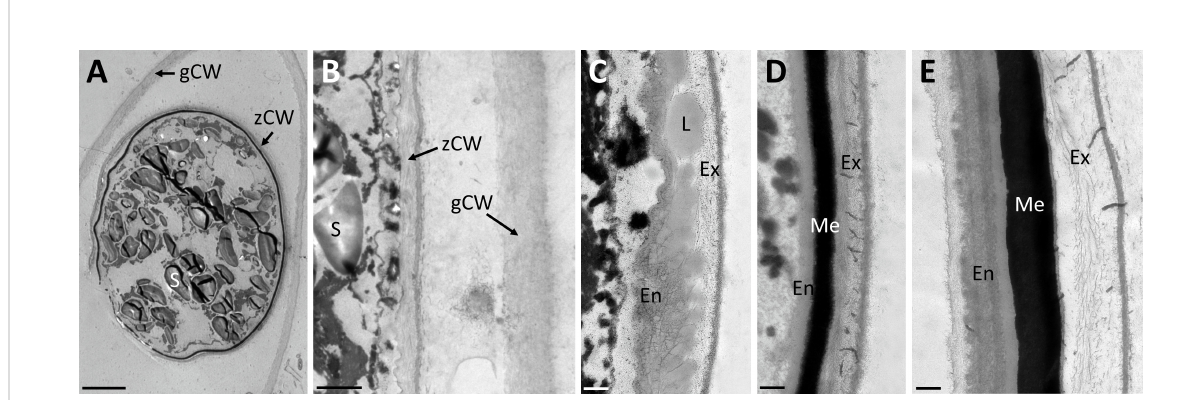
FIGURE 3 Transmission electron micrographs of high pressure frozen/freeze substituted Spirogyra mirabilis zygospores. (A) overview of a presumably young zygospore; (B) zygospore wall at an early developmental stage, comprising only two thin main layers; (C) accumulation of lipid bodies between the endo- and exospore when the mesospore is not fully developed; (D) detail view of mature zygospore wall; (E) detail view of mature zygospore wall with distinct parallel orientation of the micro fi brils in the endospore. En endospore; Ex exospore; L lipid; Me mesospore; S starch; gCW gametangial cell wall; zCW zygospore cell wall. Scale bars: (A) 5 µm; (B) 1 µm; (C – E) 250